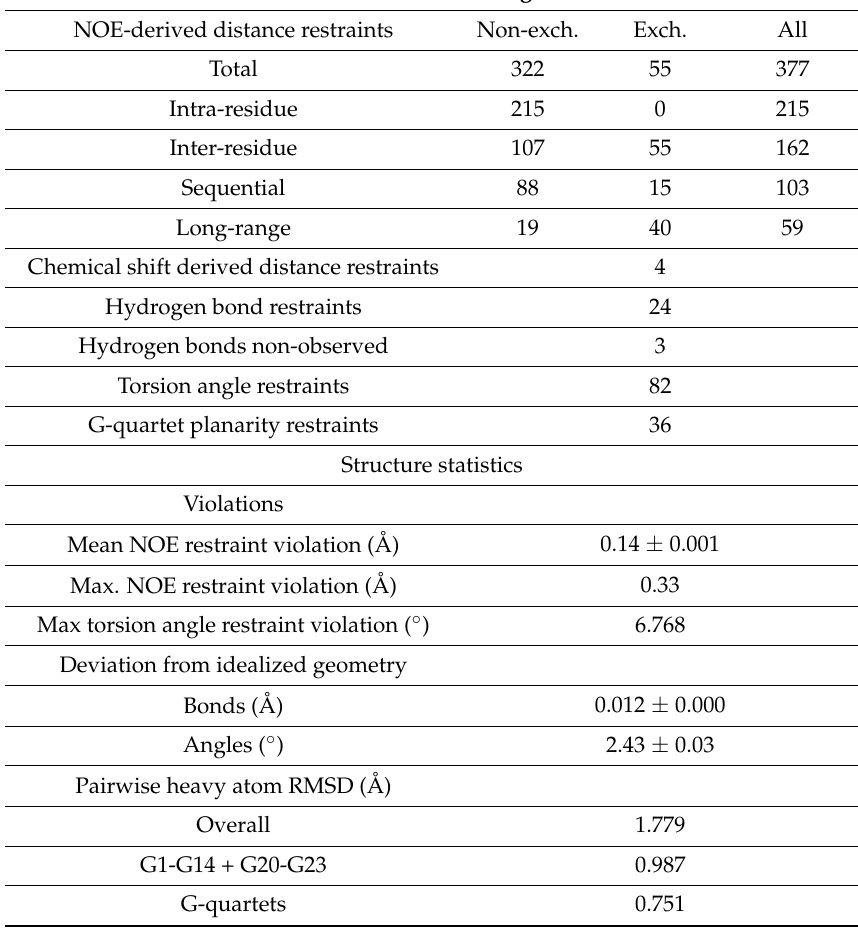
Table 1. Structural